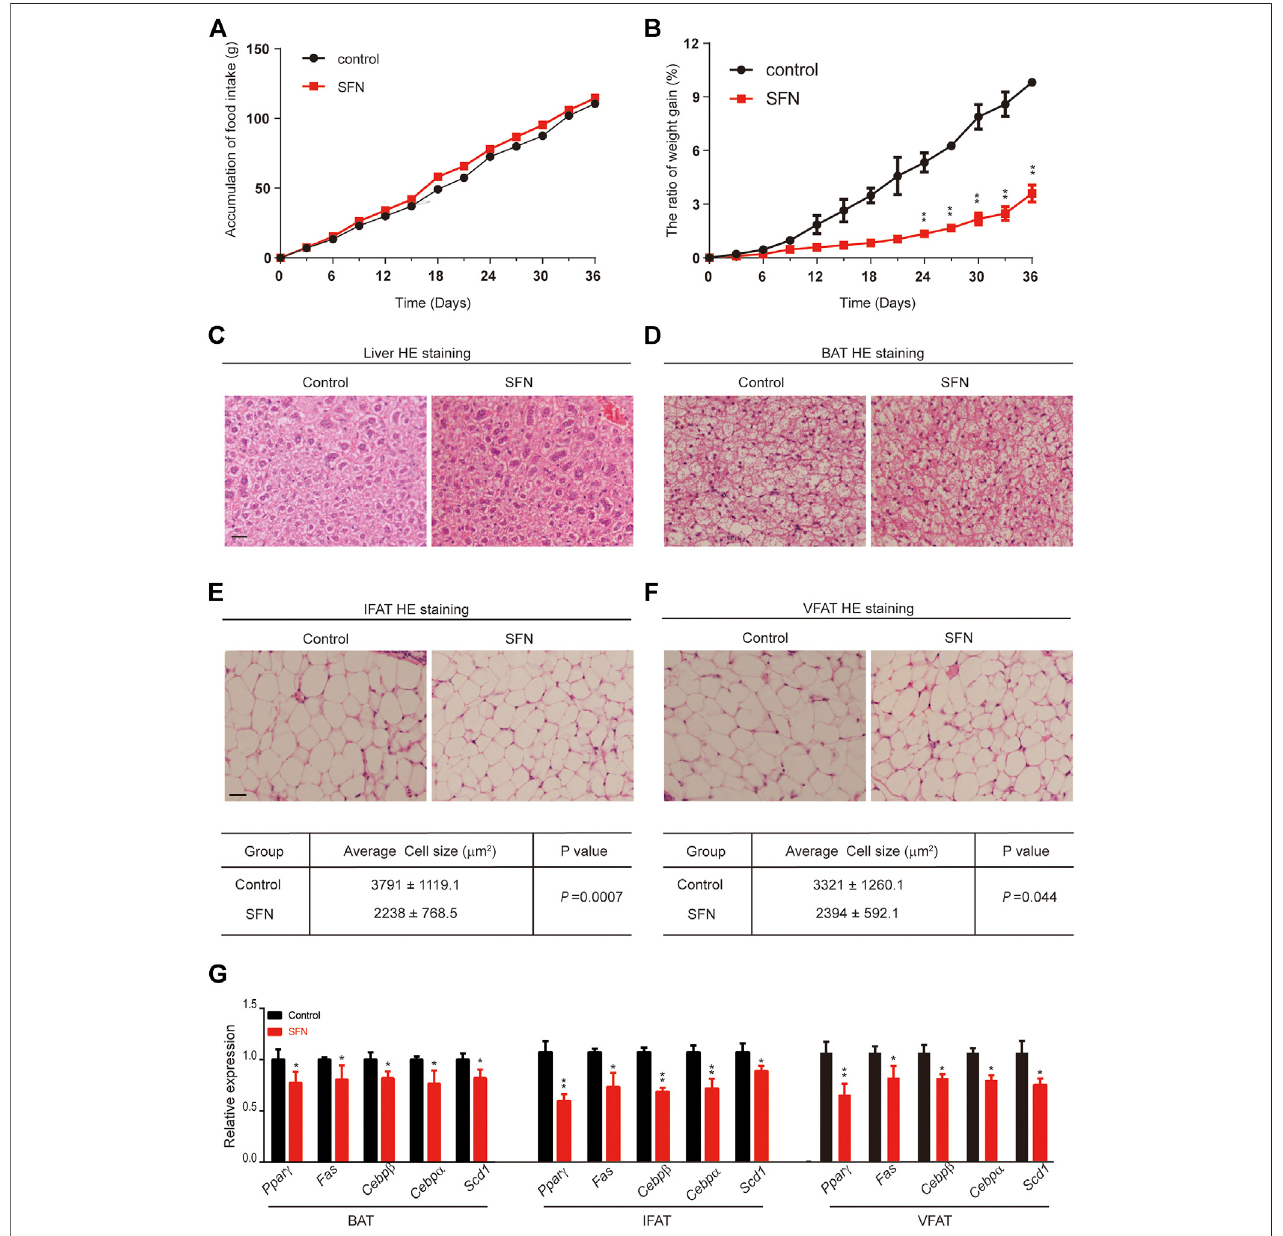
FIGURE 3 | SFN impairs adipose cell differentiation in mice fed with normal diet. (A,B) SFN did not in fl uence food intake but decreased weight gain. n (cid:2) 7/group, ** p < 0.01 vs. control. (C,D) Histology analysis of the effect of SFN on the cell morphology of the liver and BAT. (E,F) SFN decreased the adipose cell size of IWAT and VWAT. (G) SFNdecreasedtheadipogenesisgeneexpression inWAT.Scarbar (cid:2) 50 μ m.Alltheresultswereexpressed ingraphwithmean ± SD.Statisticalsigni fi cance was evaluated by Student t test. * and ** represent the signi fi cant difference at p < 0.05, p < 0.01 vs control